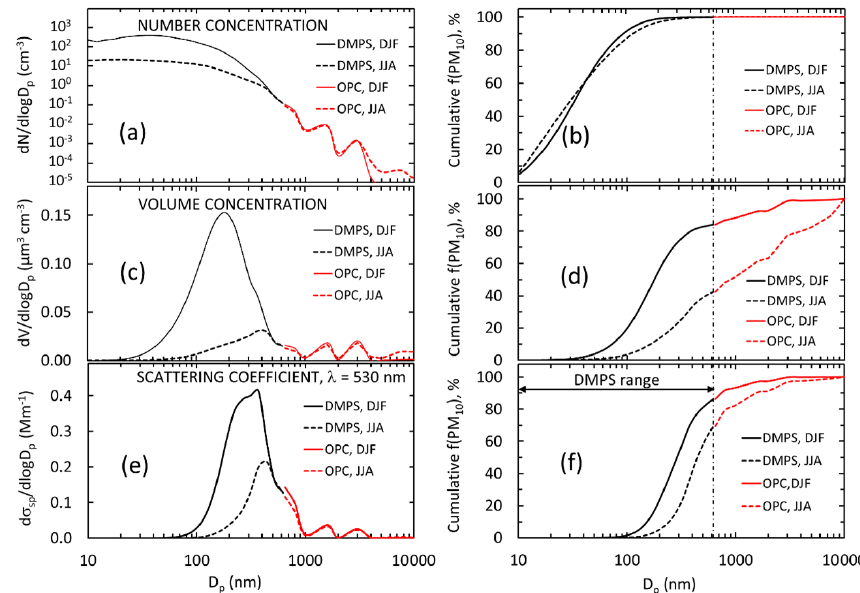
Figure 2. Average particle size distributions in summer (DJF) and in winter (JJA) in December 2007–July 2009 when both the DMPS and the Grimm OPC were operational. Left: average and median (a) number, (c) volume, and (e) scattering size distributions at λ = 530nm; right (b, d, f) : cumulative fractions of the respective parameters in the size range D p < 7 . 5µm, which corresponds to the aerodynamic particle size range D a < 9 .